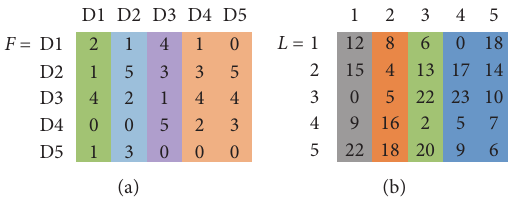
Figure 6: Flow and distance matrixes of the hospital departments.